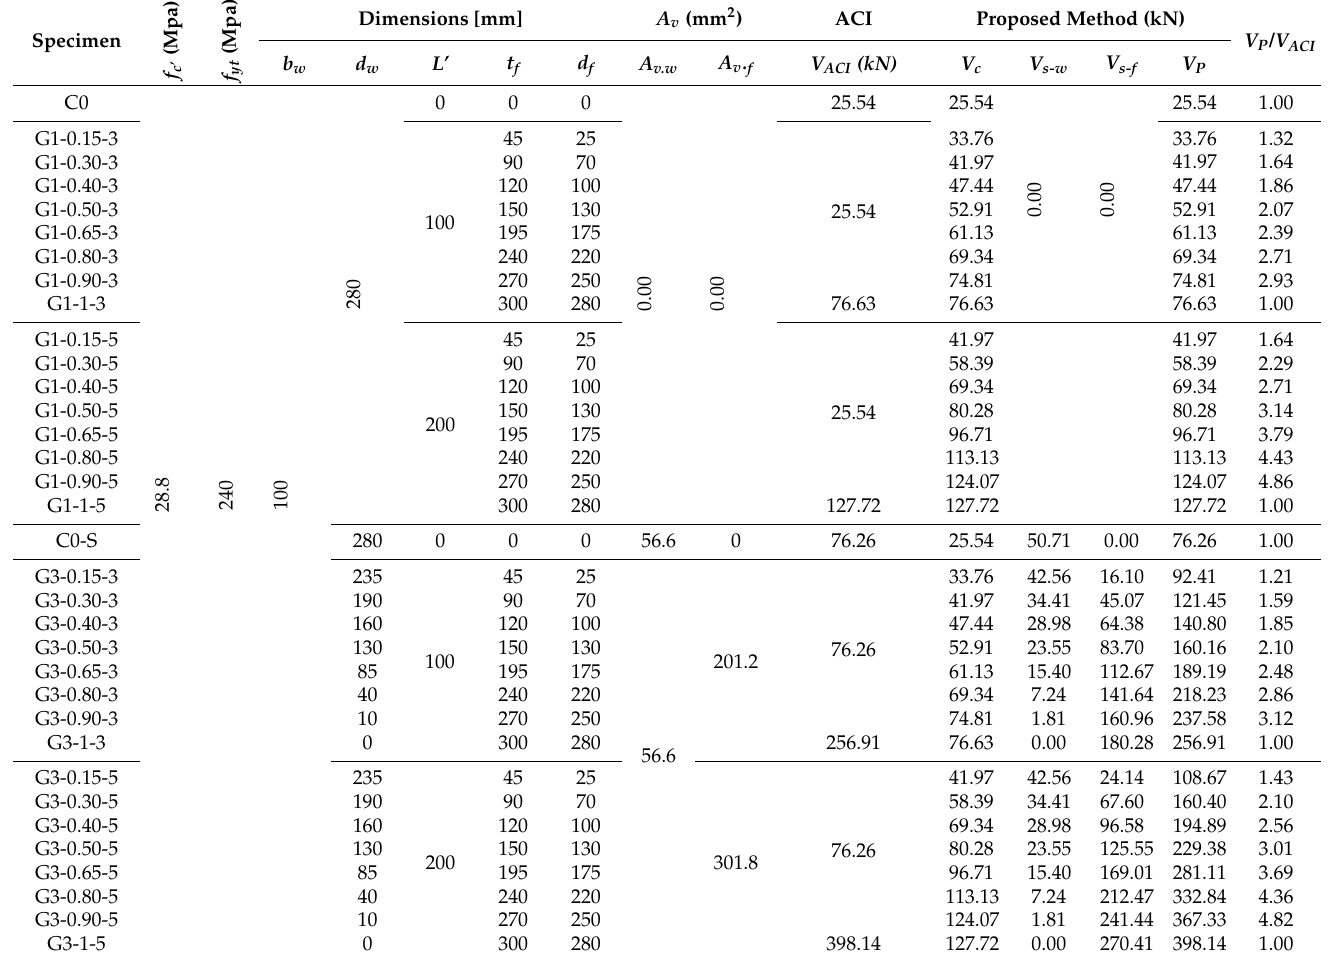
Table 4. Comparison of proposed equation with